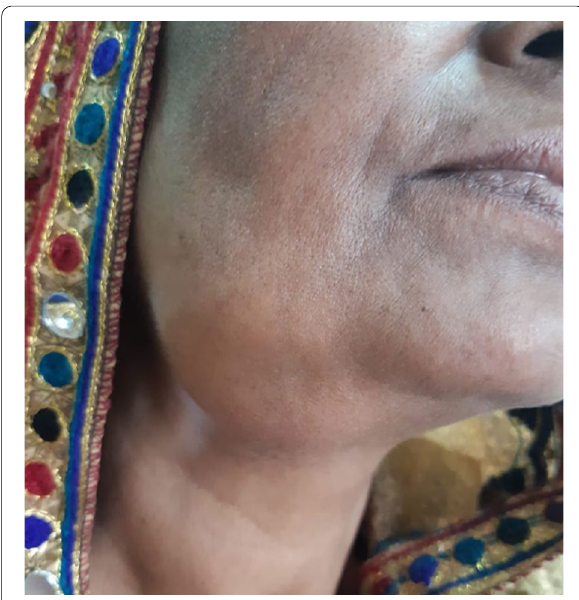
Fig. 1 The extraoral presentation of swelling in the submandibular region